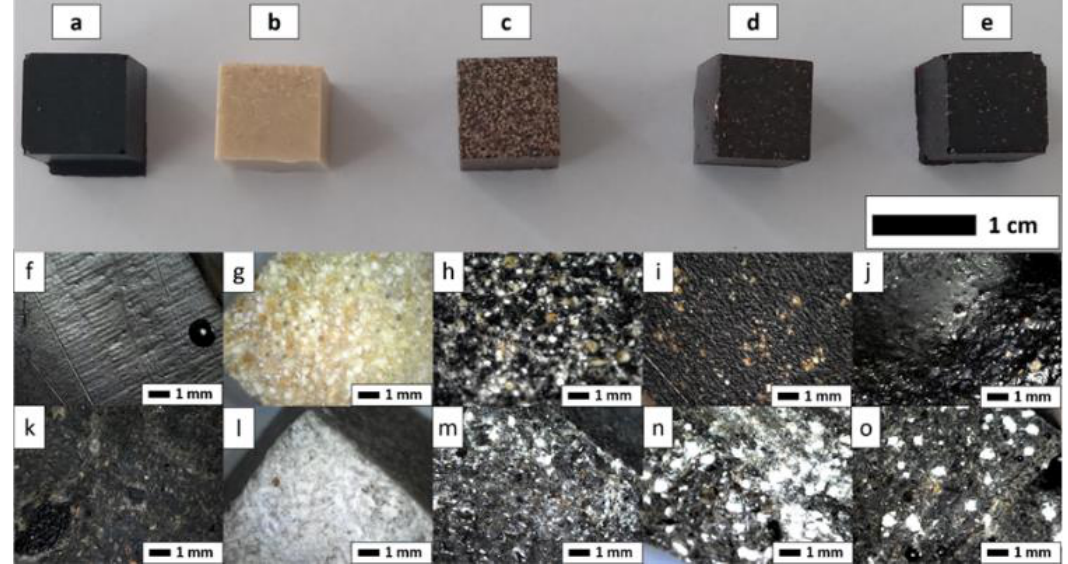
Fig. 4. Photograph image of the successfully fabricated brake pad. Figures (a-e) are the brake pads prepared with BP, E, E/BP1, E/BP2; and E/BP3, respectively. Figures (f-j) are the outer surface of the brake pads; and Figures (k-o) are the inner surface of the brake pads. Figures (f,k), (g,l), (h,m), (i,n), and (j,o) are samples using BP, E, E/BP1, E/BP2, and E/BP3,